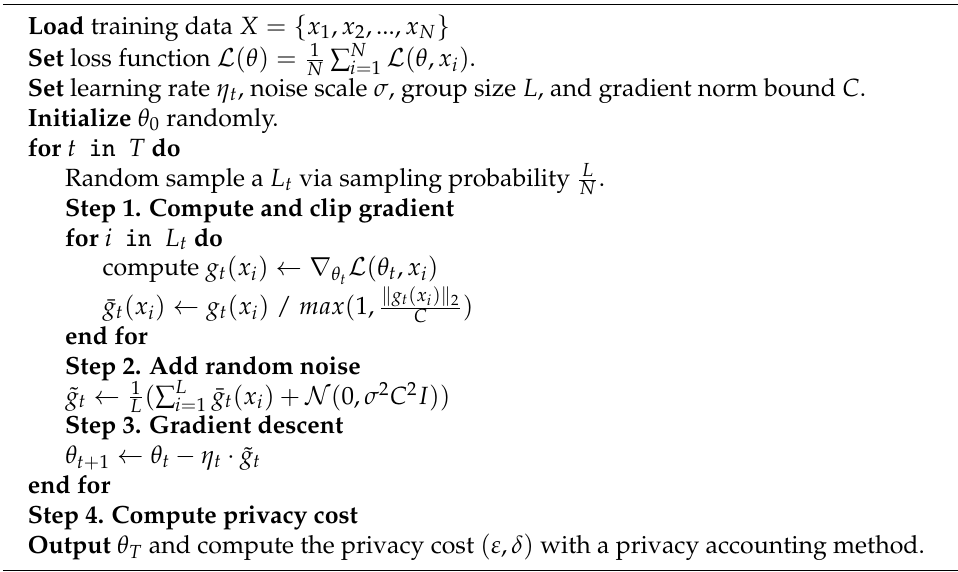
Algorithm 1 Differentially Private Stochastic Gradient Descent